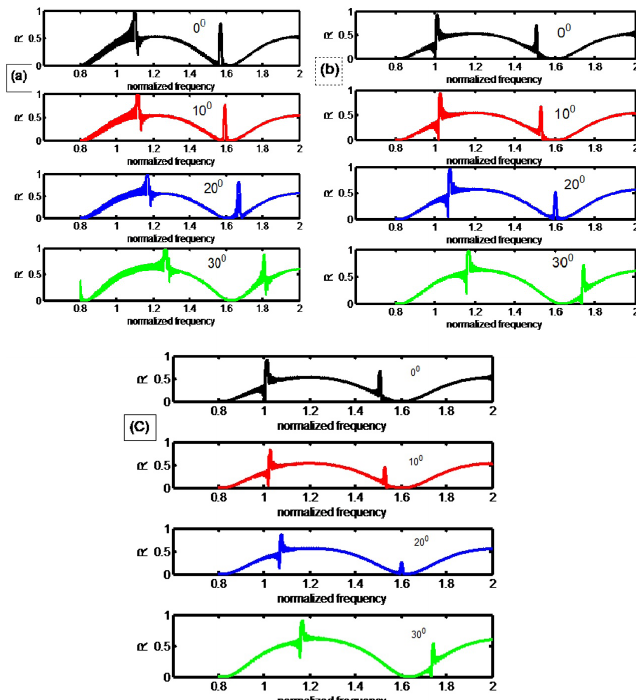
Figure 3. Reflectance spectra versus normalized frequency of the three heterostructures and for different wave incidence angles.